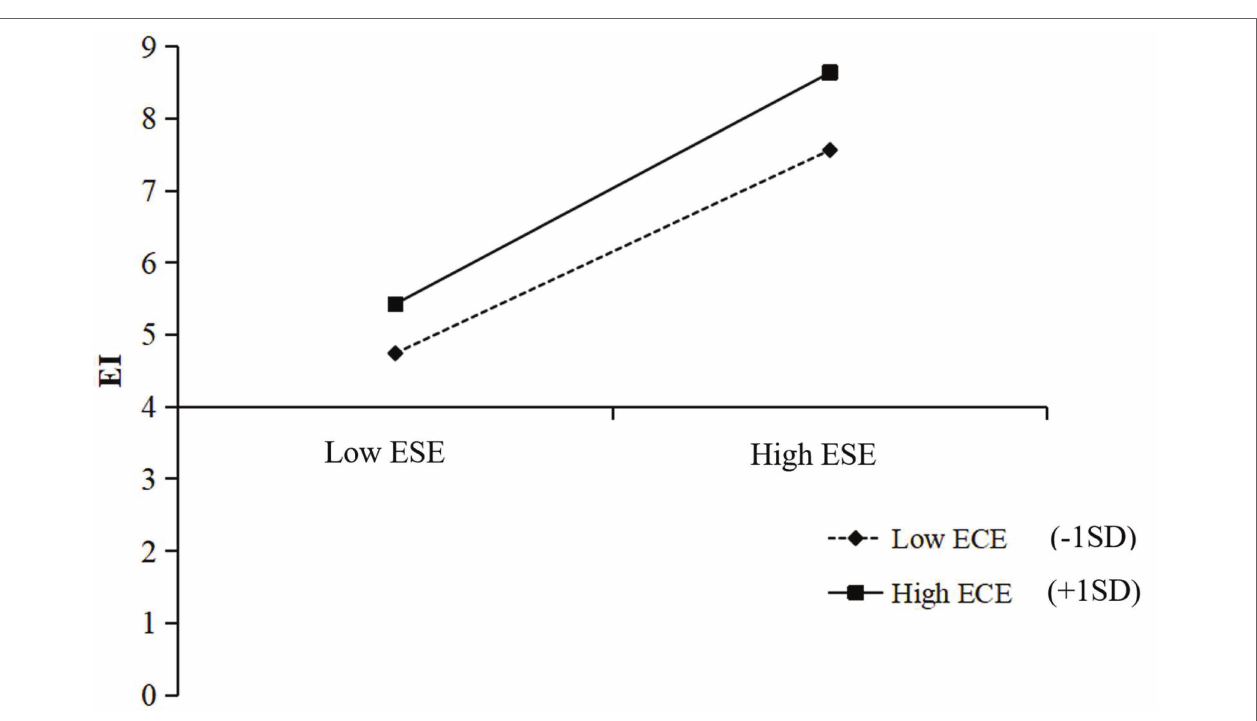
FIGURE 2 | EI as a function on ESE and ECE. Simple slope analysis showed that ECE moderated the relation between ESE and EI. The function was graphed for two levels of independent variable and moderator: 1 SD above the mean and 1 SD below the